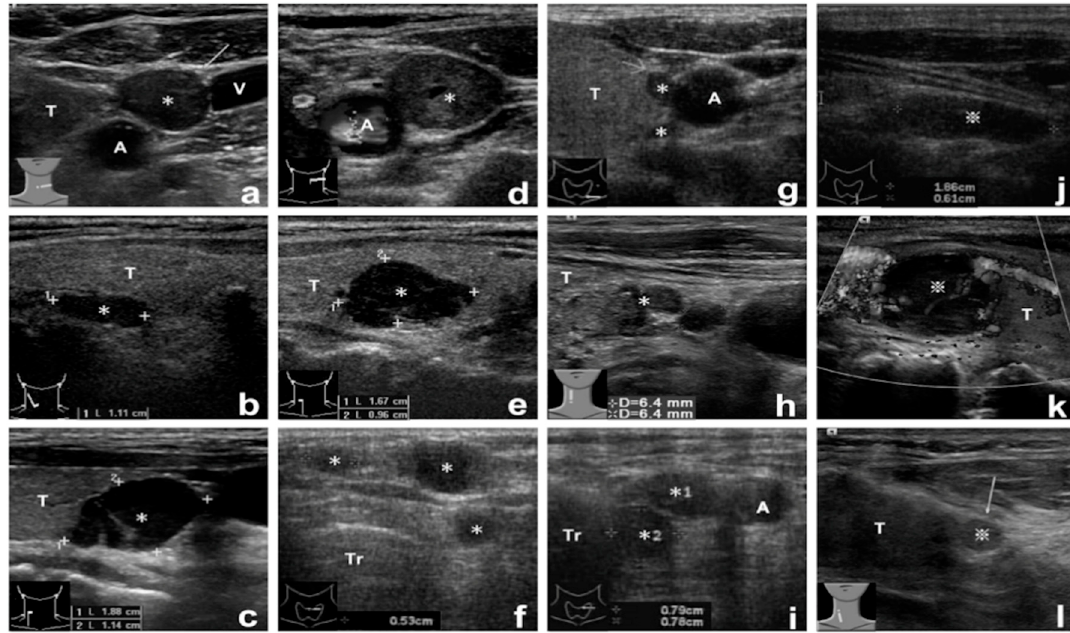
Figure 1. Images of positive and suspicious parathyroid sonography lesions. ( a–c ) Case 1, 2, 6, with positive sonographic lesions. ( d ) Case 5, with suspicious left upper neck lesion. ( e ) Case 20, with suspicious intrathyroid lesion. ( f ) Case 24, with suspicious multiple subcutaneous lesions. ( g ) Case 25, with suspicious dumbbell shape lesion. ( h ) Case 8, with suspicious infrathyroid lobulated lesion. ( i ) Case 26-1, with suspicious multiple paratracheal lesions. ( j ) Case 14, with suspicious intrathymus lesion (false assay-negative). ( k ) Case 31, with suspicious intrathyroid lesion. ( l ) Case 26-2, with suspicious infrathyroid small lesion. ✻ Positive tissue aspirate PTH assay lesions. ※ Negative tissue aspirate PTH assay lesions. Demographic data of enrolled patients are listed in Table S1. Abbreviations: A, common carotid artery; V, internal jugular vein; T, thyroid; Tr, trachea.